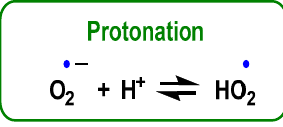
Figure 5. Protonation of O 2• − leads to the formation of HO 2• .